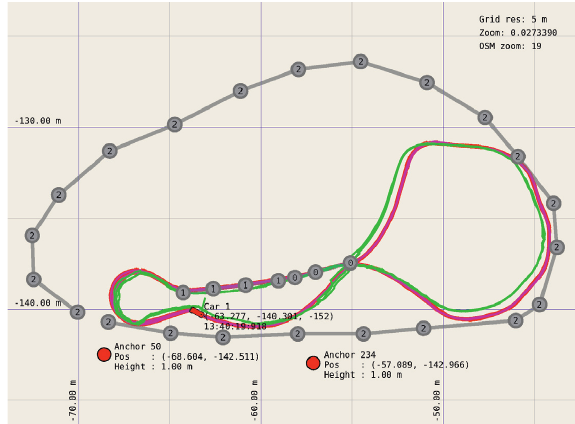
Figure 16: The same test as in Figure 14, but with FI disabled. The traces for repetition runs are overlayed, and mostly overlapping, maximum UWB deviation: 0.55m.